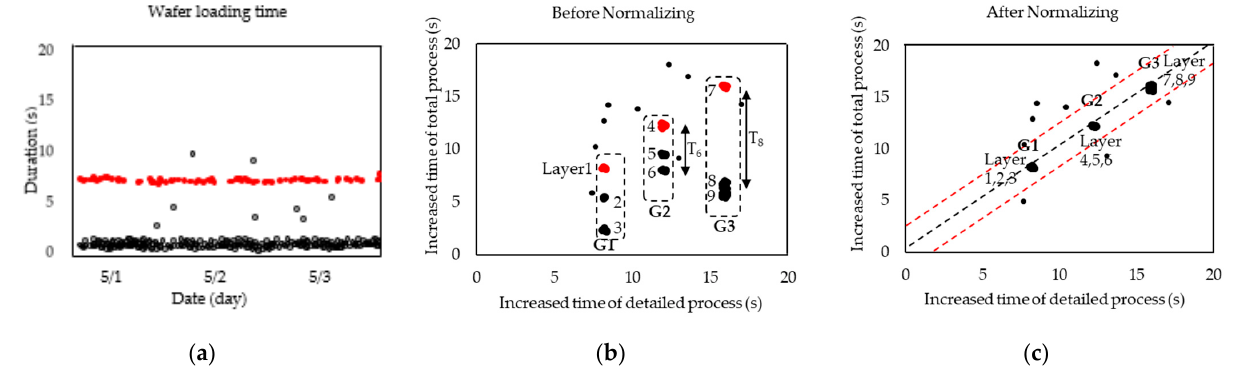
Figure 3. ( a ) Shows wafer loading time of each wafer, where red data are clustered in a specific time range. ( b , c ) Show the process of normalization, where each layer has different waiting times (T i ) for normalization.